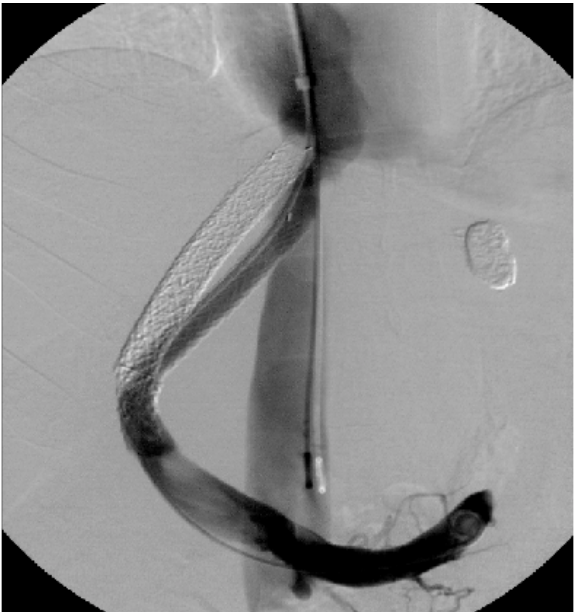
Figure 5. A 16-year-old female patient with fulminant Budd–Chiari syndrome due to essential thrombocytosis received a TIPS in 1998. Between 1998 and 2013, seven TIPS revisions were performed